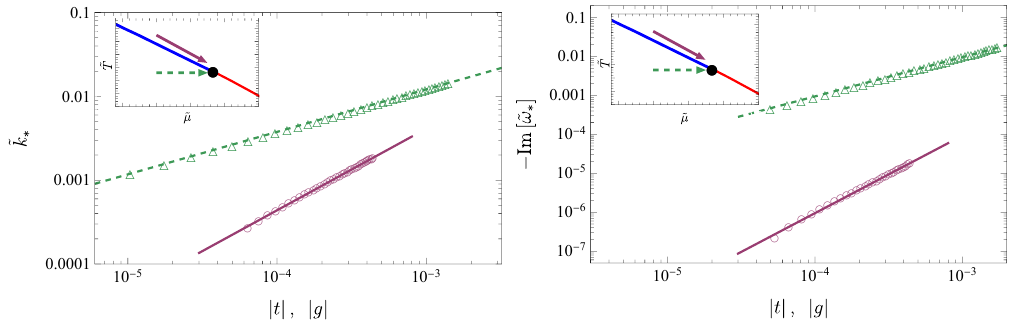
Figure 12 . The left and right panel shows the critical behaviors of k ∗ and ω ∗ in log scale, respec- tively. Each plot shows the critical behaviors for the two different paths denoted by the arrows in the